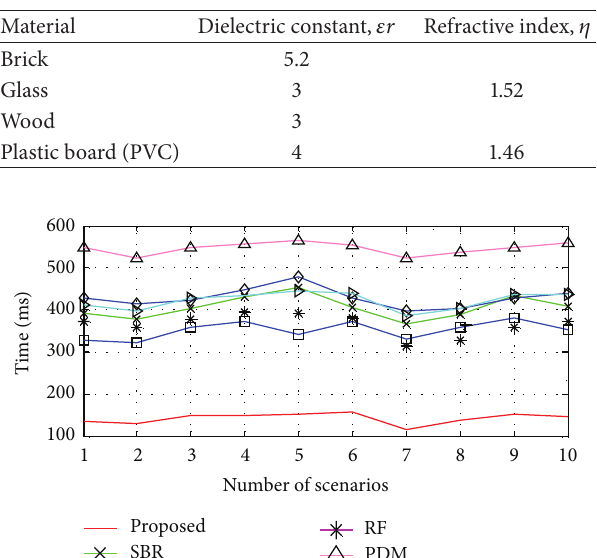
Table 4: Properties of different materials.